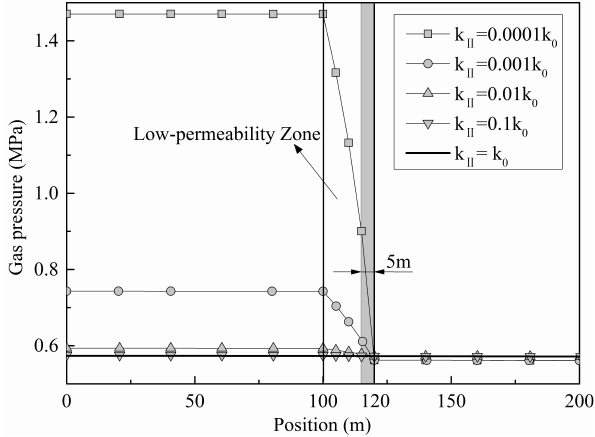
Figure 8. Gas distribution after 10 5 years of gas migration.